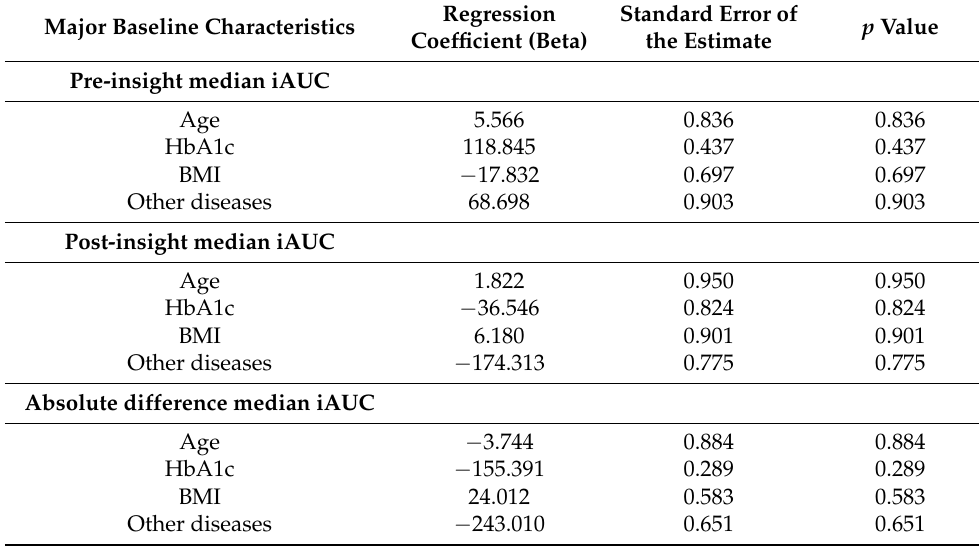
Table 3. Multiple linear regression analysis of baseline characteristics and glycaemic